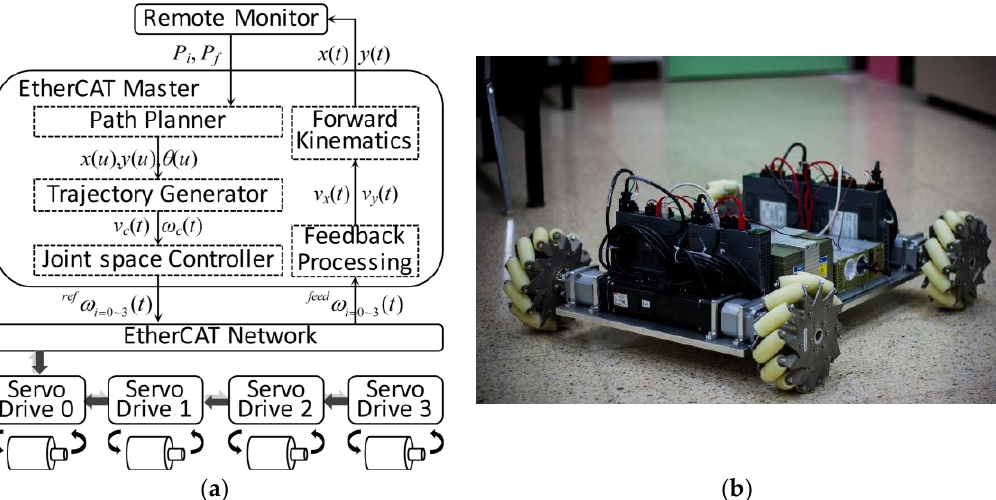
Figure 8. EtherCAT-based omnidirectional mobile robot: ( a ) Control architecture; ( b ) Actual image of the mobile robot.